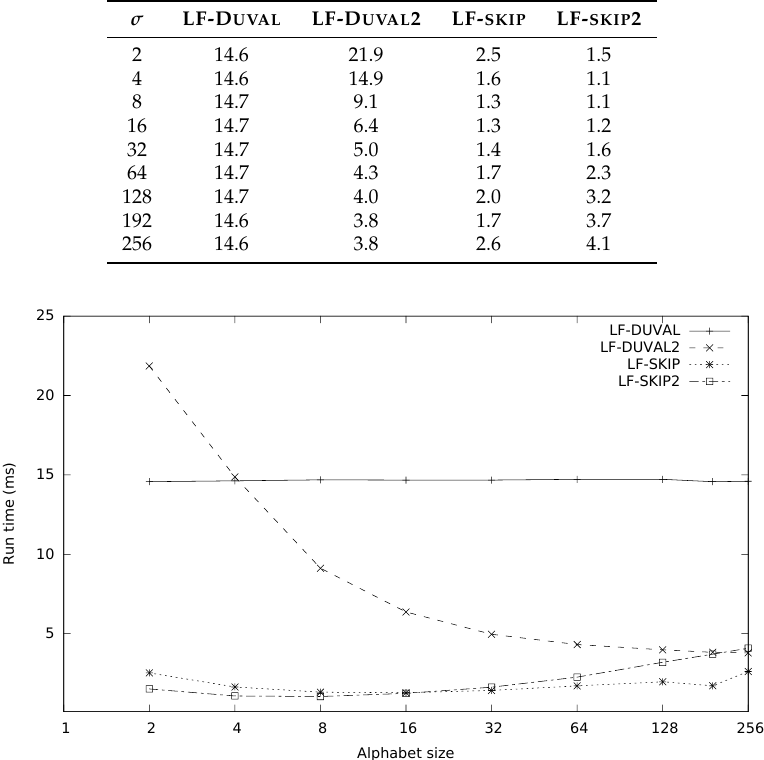
Figure 4. Comparison of the algorithms on random sequences (5 MB) with a uniform distribution of a varying alphabet